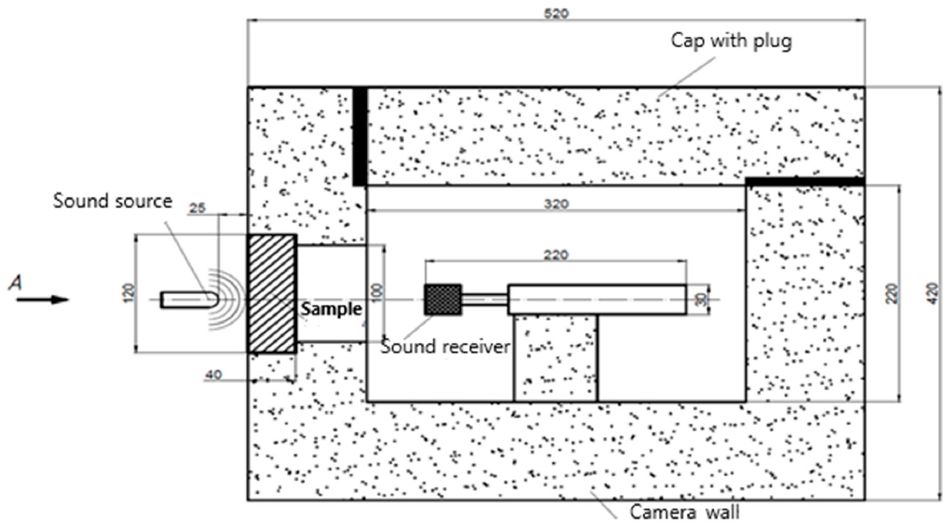
Figure 6. Schema of the sample test bench for sound absorption.